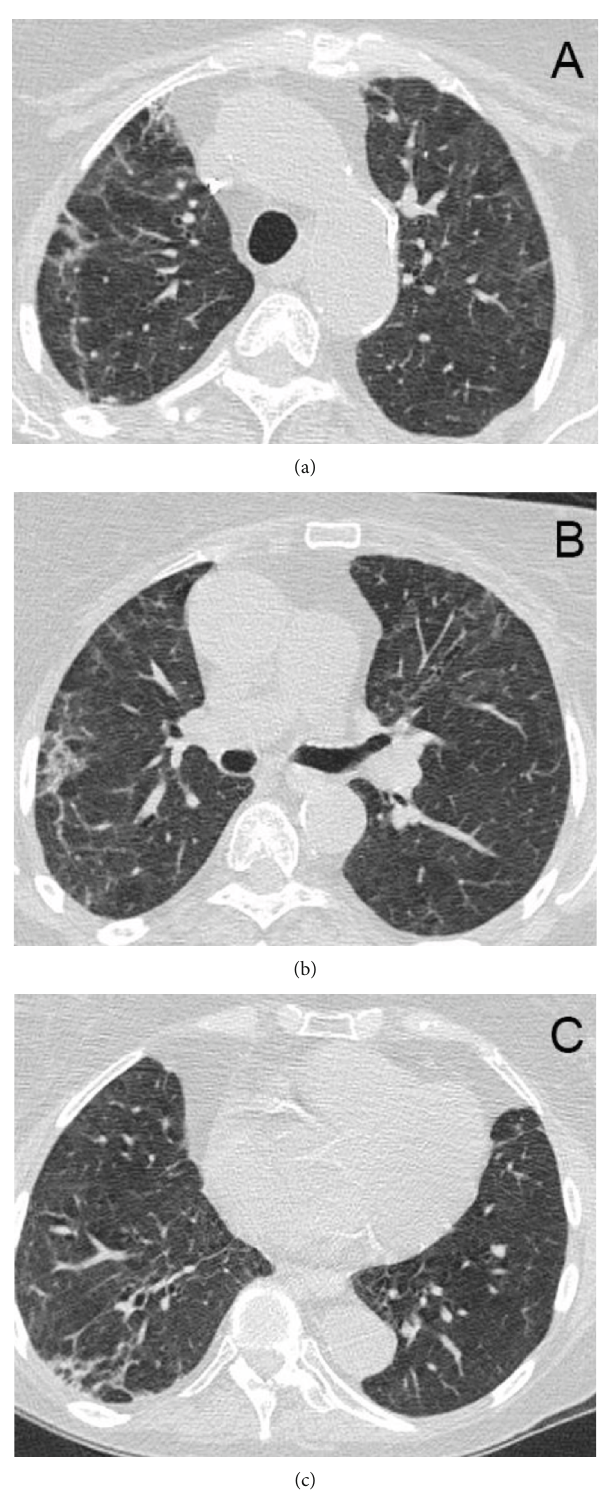
Figure 4: Imaging on 48 days after a discharge CT scan of the lungs at upper (a), mid (b), and base (c) illustrating improved residual ground glass and reticular opacities